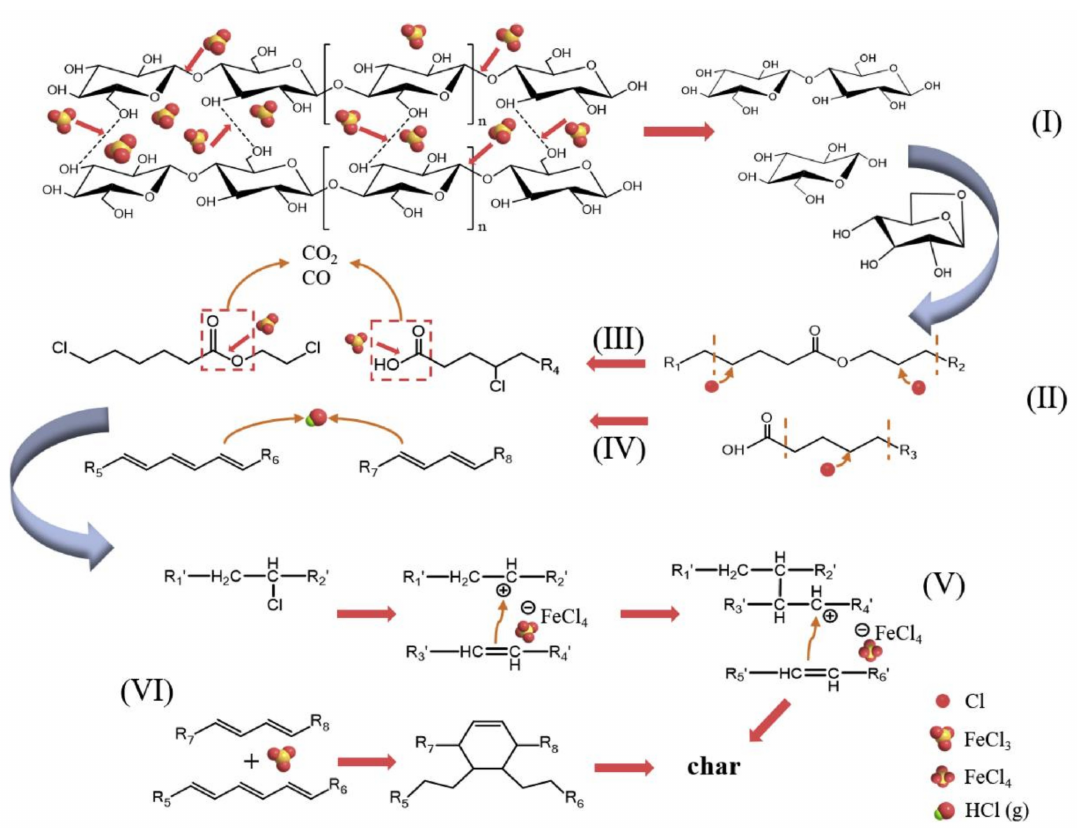
Figure 2. Activation of cotton waste with FeCl 3 (reprinted from [45] with the permission of Elsevier,